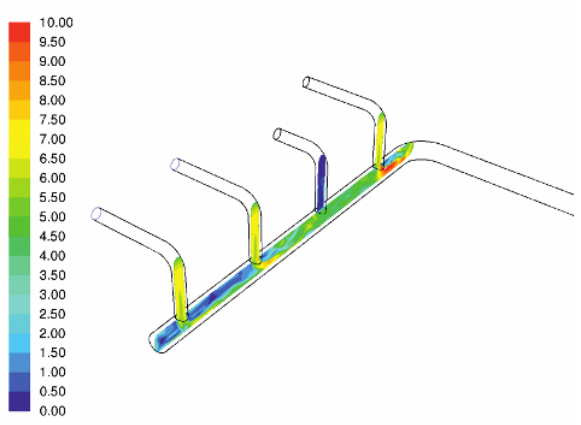
Figure 6: Velocity field at the inlet part